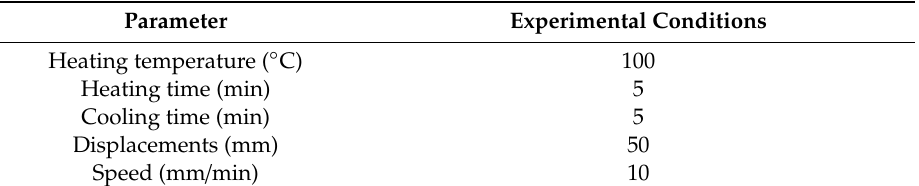
Table 5. Detailed experimental conditions for investigating the shape-recovery characteristics.